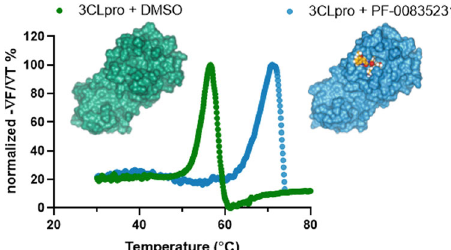
Fig. 1 Representative thermal shift binding data of PF-00835231 with SARS-CoV-2 3CL pro . X-ray structures of SARS CoV-2 3CL pro apoenzyme (left) and SARS CoV-2 3CL pro in complex with PF-00835231 (right). Representative of melting curves with and without PF-00835231 ( n = 8, n = 16 respectively).